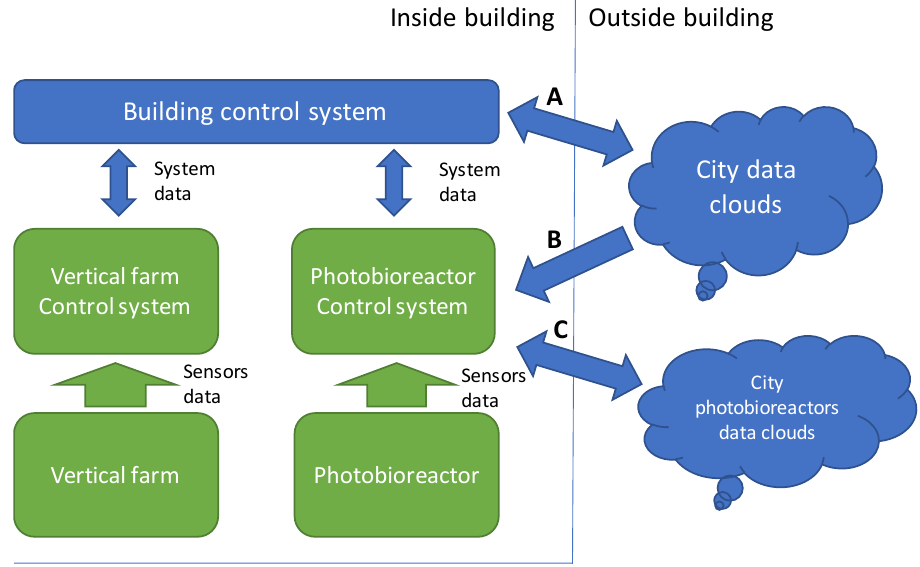
Figure 4. Data flows between photobioreactors, vertical farming systems, and building control systems. ( A ) City data transfer to a photobioreactor control system through a data exchange with a building control system; ( B ) data transfer directly to a photobioreactor control system; ( C ) data exchange between a photobioreactor control system and data clouds containing data from all photobioreactors in the city.